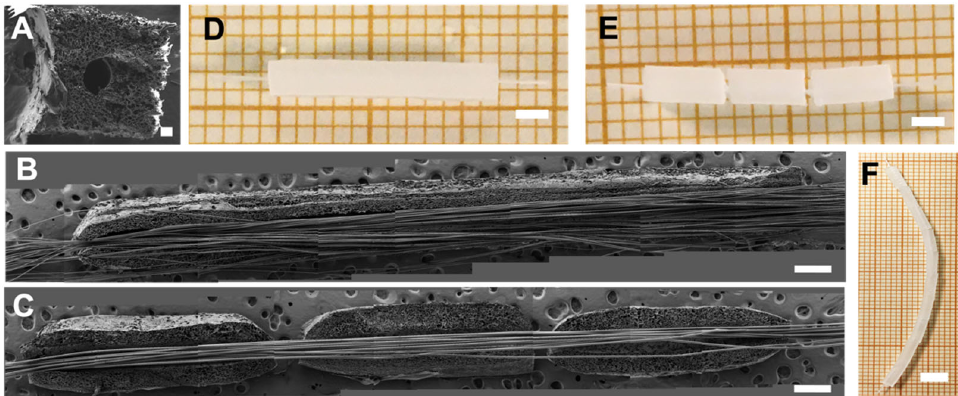
Figure 3. Unimodular and multimodular conduits concept. Scanning electron microscope images from a transversal cut ( A ) of a hyaluronic acid conduit, and a longitudinal cut of ( B ) unimodular and ( C ) multimodular conduits (only the part with de PLA fibers is shown). Macroscopical view of hydrated ( D ) unimodular and ( E ) multimodular conduits, and a ( F ) multimodular conduit formed by 10 modules in order to cover a long and curved distance. The distances between the modules in multimodular conduits is exaggerated for better visualization. Scale bar: 5 mm ( F ), 2 mm ( D , E ), 500 μ m ( B , C ), 100 μ m ( A ).